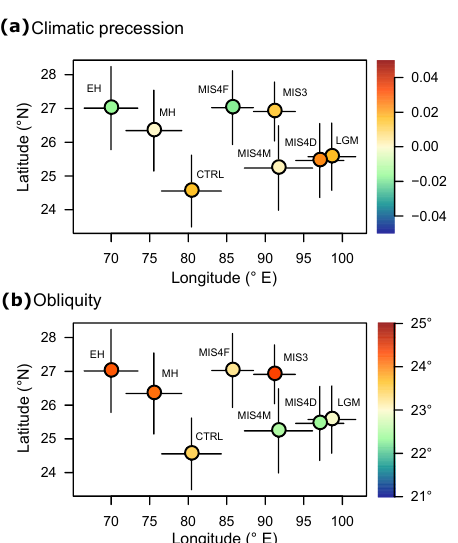
Figure 12. Mean (a) climatic precession ( e · sin( ω − 180 ◦ ) where e is the eccentricity and ω − 180 ◦ is the precession) and (b) obliq- uity values as a function of the longitude and latitude of the SLPa-5 barycentre for the eight climate simulations. Errors bars give the standard deviation of the SLPa-5 position over the 100 summers of each